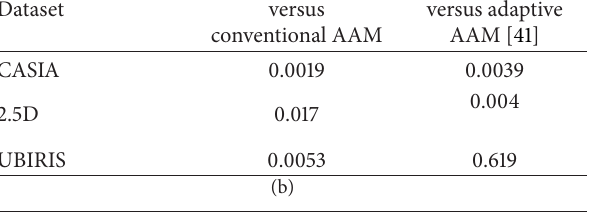
Table 13: Proposed and conventional AAM techniques fitting error of (a) CASIA face images dataset, (b) 2.5D face dataset, and (c) UBIRIS dataset. (a) Fitting error